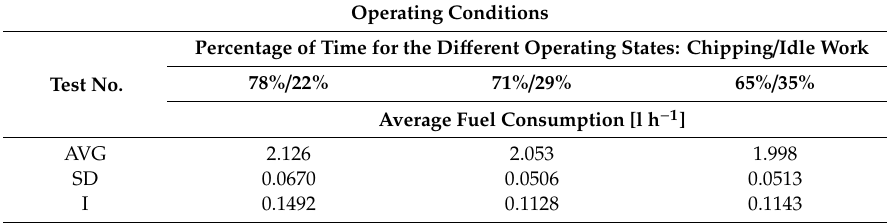
Table 4. The results of fuel consumption of the cylindrical wood chipper with carburetor fuel supply system (A) in periodically-variable exploitation conditions (3); AVG–arithmetic average,